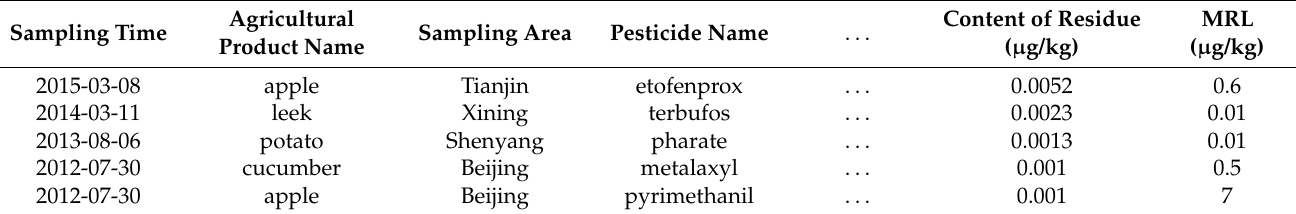
Table 4. Data records (partially) in